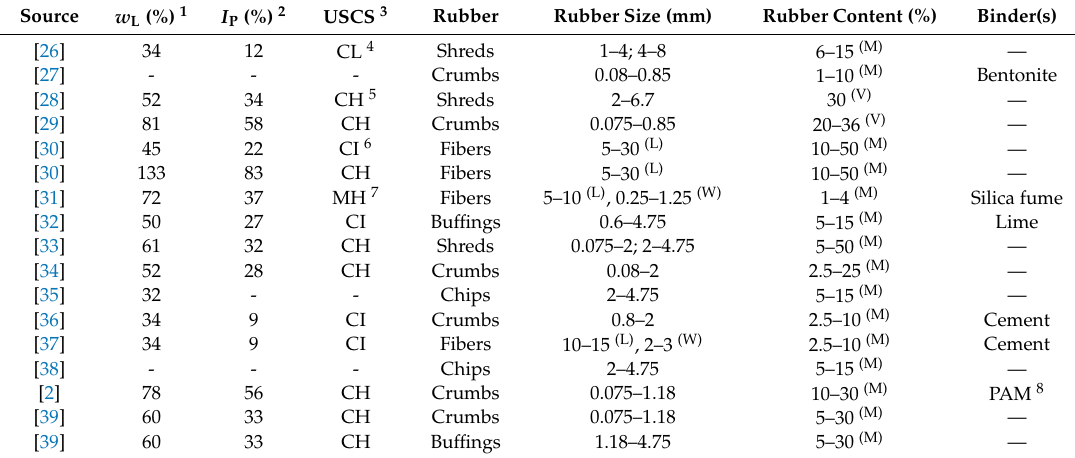
Table 1. Recent contributions addressing the swelling behavior of rubber mixed expansive